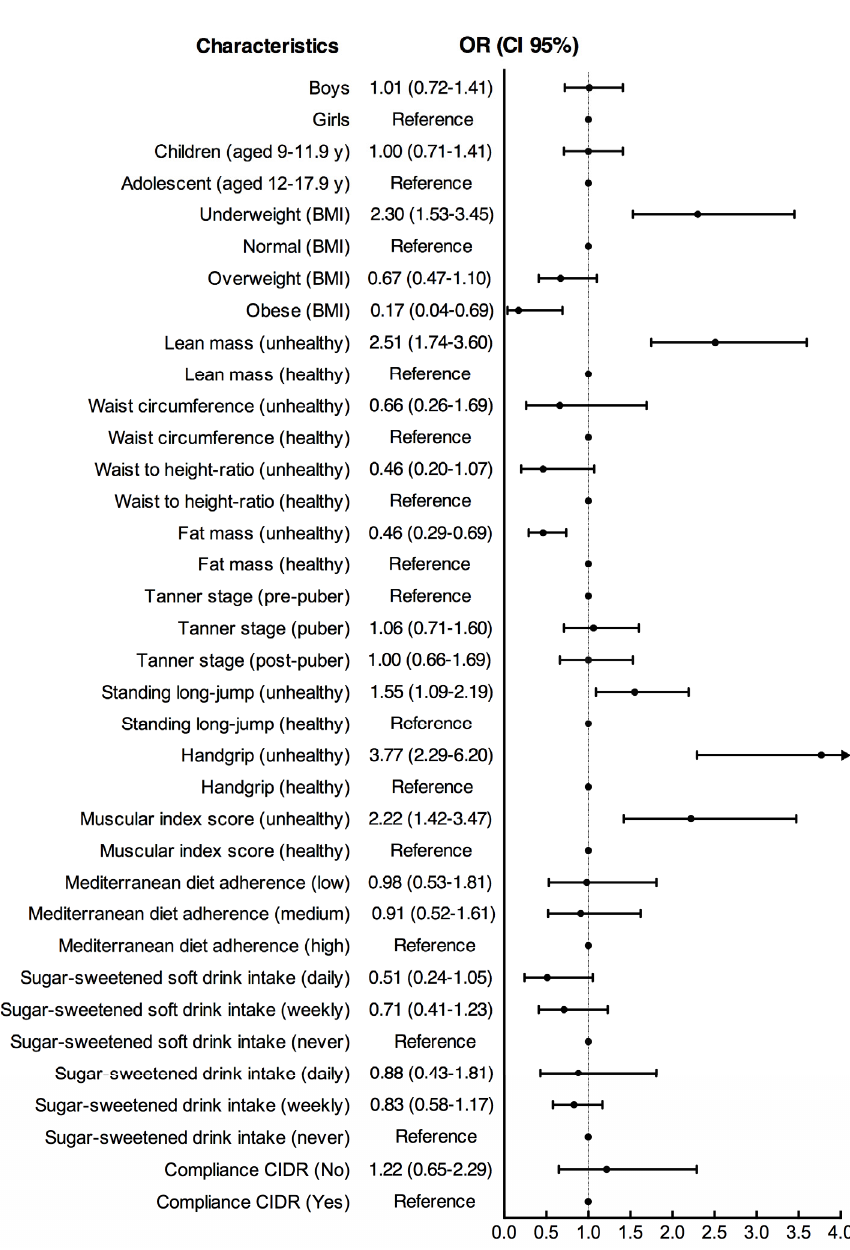
Figure 1. Factors associated with poor bone health.